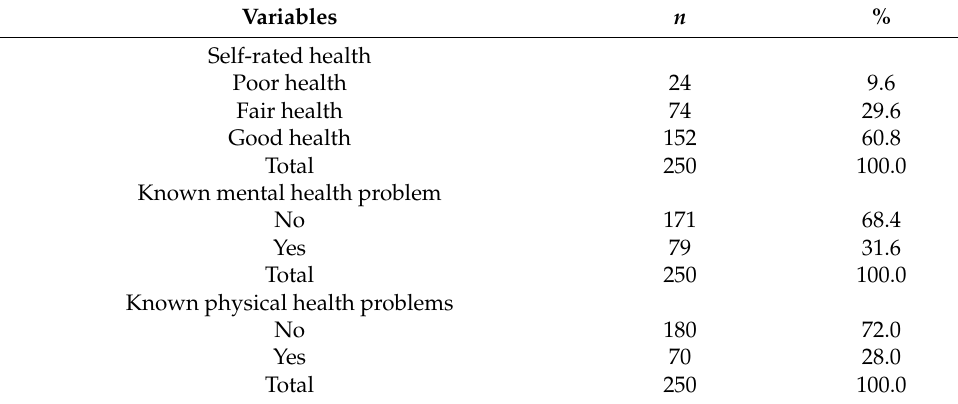
Table 2. Health needs and services of